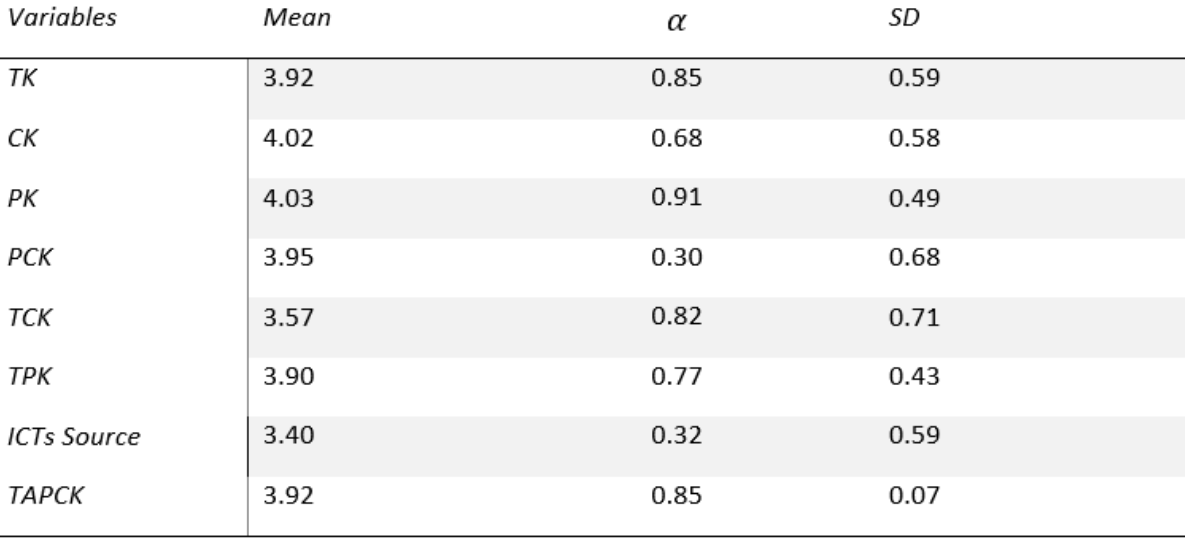
Table 2. Descriptive statistics on TPACK perceived